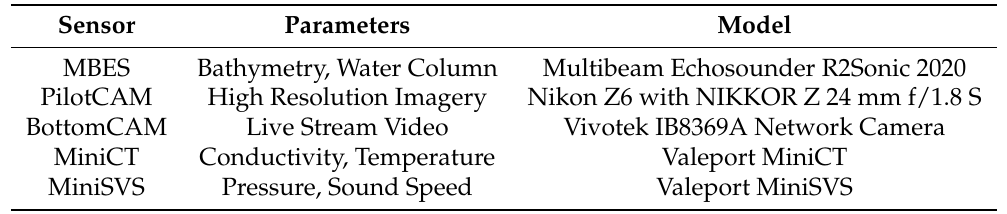
Table 2. Instruments for scientific